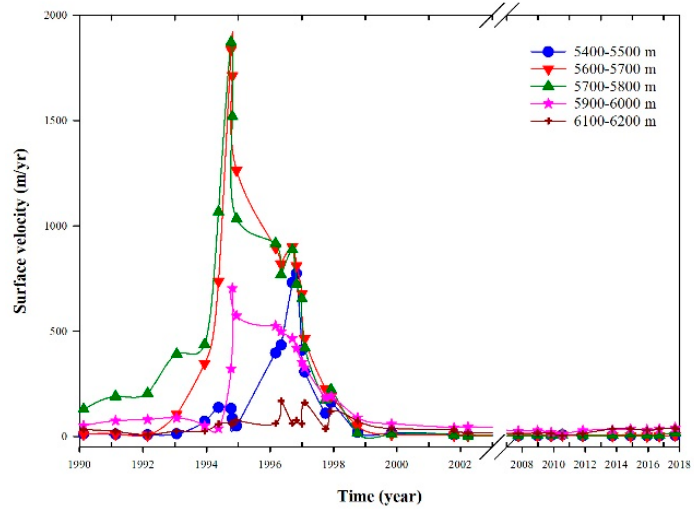
Figure 7. The glacier velocity changes from 1990 to 2020 at different elevations.